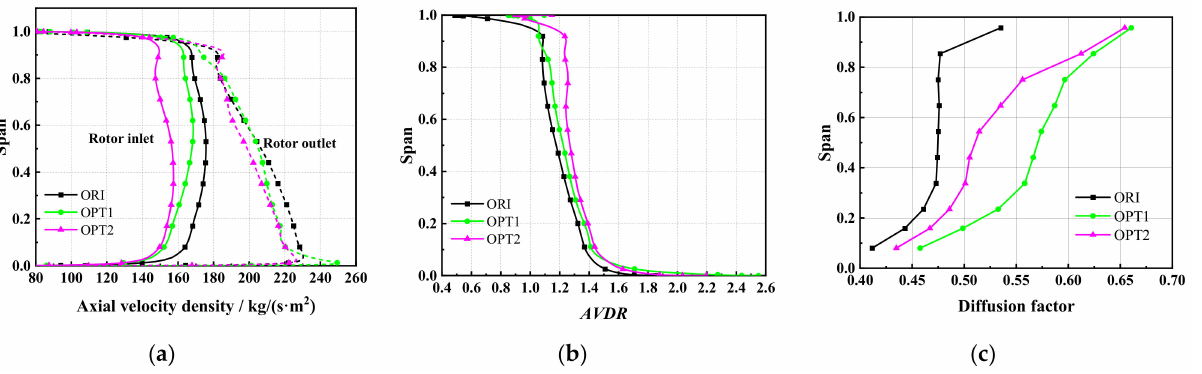
Figure 15. Spanwise distributions of the AVDR and diffusion factor for rotors at the near stall point: ( a ) axial velocity density at the rotor inlet and outlet; ( b ) AVDR; ( c ) rotor diffusion